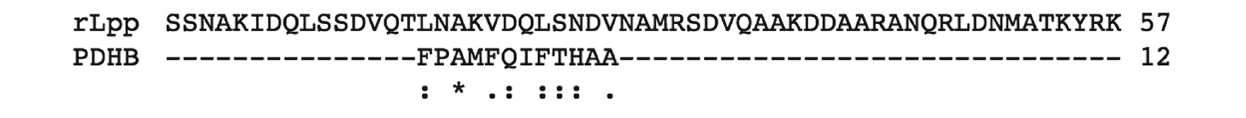
FIGURE 7 | The putative Plg-binding domain of rLpp is similar to that of another moonlighting protein. A Clustal W2 alignment of rLpp and a previously described Plg-binding peptide from PDHB of Mycoplasma pneumoniae .